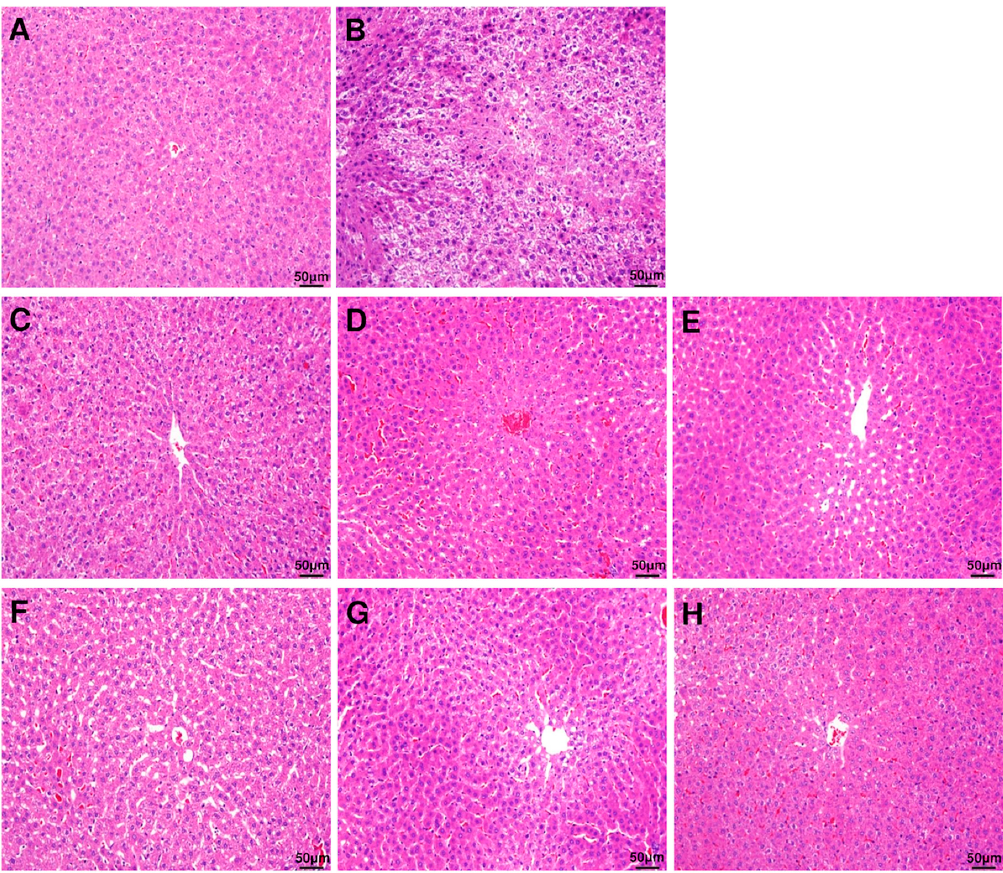
Figure 2. Histopathological evaluation (H&E staining) of rat liver. Liver section images of ( A ) control group, ( B ) ethanol group, ( C ) EtOH + DMLDE 100 mg / kg, ( D ) EtOH + DMLDE 300 mg / kg and ( E ) EtOH + DMLDE 500 mg / kg ( F ) EtOH + DMLEE 100 mg / kg, ( G ) EtOH + DMLEE 300 mg / kg and ( H ) EtOH + DMLEE 500 mg / kg display histopathological changes in liver.